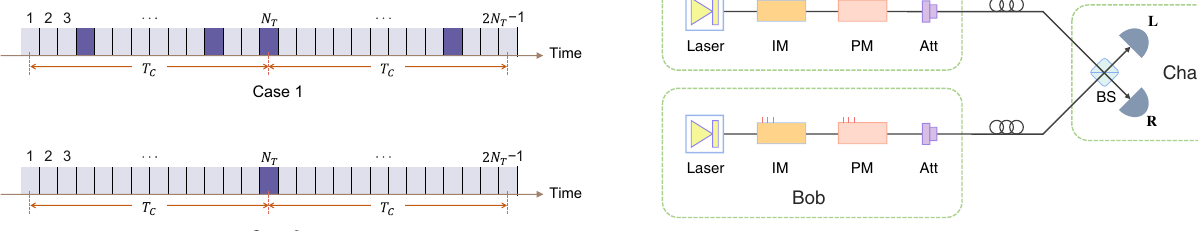
FIG. 3. Schematic of the setup for the asynchronous- MDIQKD protocol. Alice and Bob utilize a narrow-linewidth continuous-wave laser, intensity modulator (IM), phase modu- lator (PM), and attenuator (ATT) to prepare phase-randomized weak coherent pulses with different intensities and phases. Char- lie performs interference measurement with a beam splitter (BS) and single-photon detectors. Charlie announces the detection events where only the detector L or R